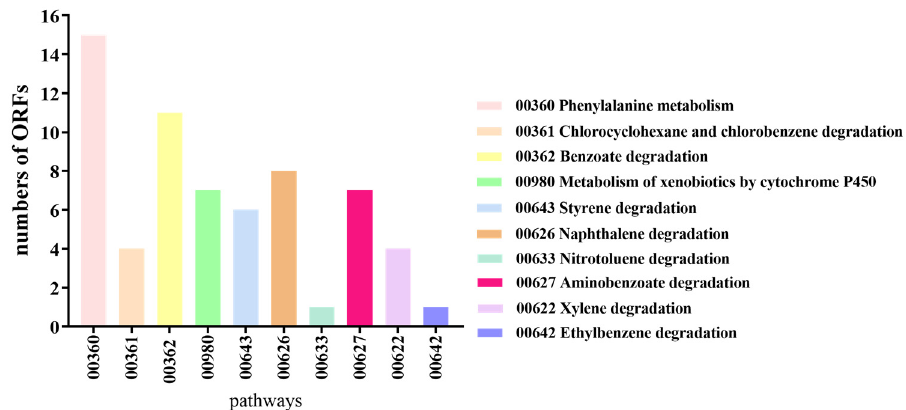
Figure 5. The number of genes of B. cereus AH7-7 enriched in KEGG pathways related to aromatic degradation.